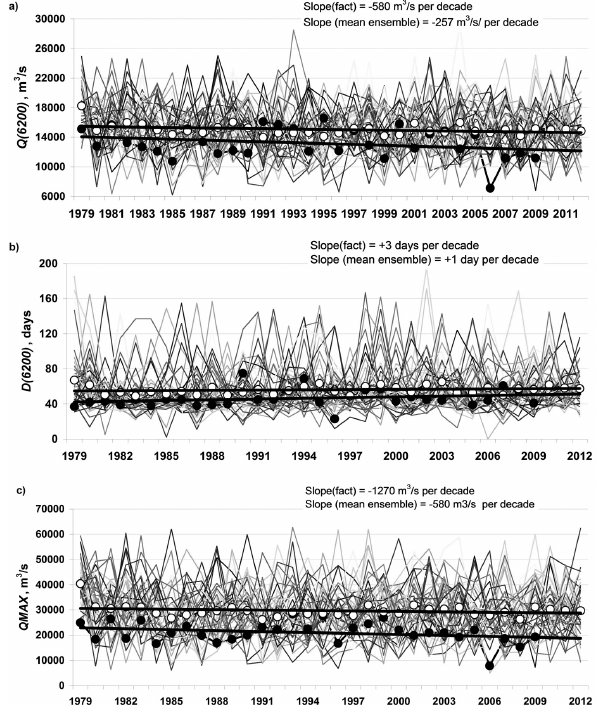
Figure 3. Observed (line with black markers) and simulated series of above-threshold average annual discharge (a) , above-threshold hydrograph duration (b) and annual maximum daily discharge (c) . Lines with white markers show the ensemble-averaged variables, thick lines show trends of the observed and the ensemble-averaged time series.